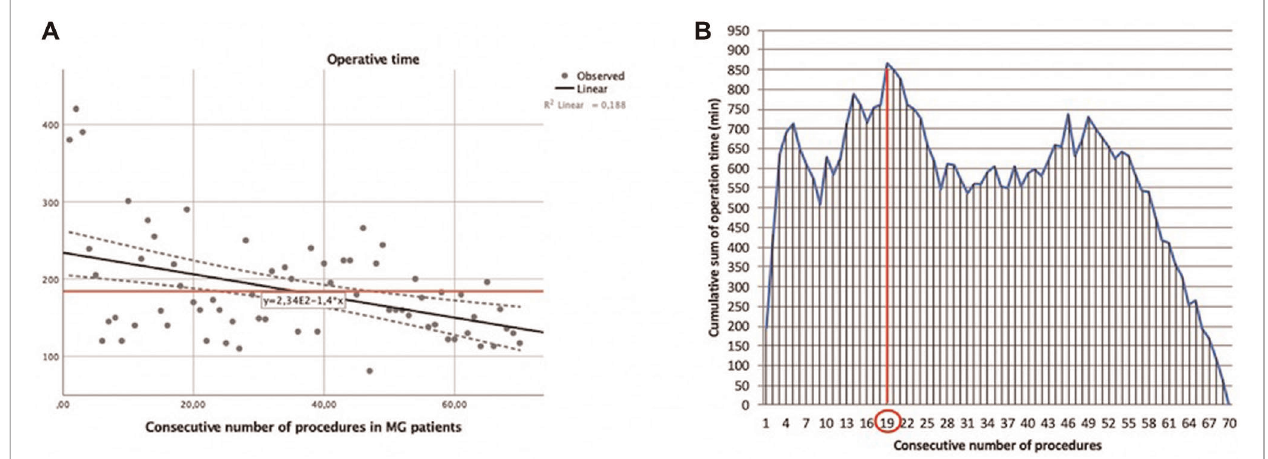
FIGURE 3 | Learning curve of robot-assisted myasthenic thymectomies. ( A ) Correlation between the operation time and the consecutive number of procedures [the red line represents the average time; the Pearson correlation coef fi cient ( r ) of linear function is − 0.433]; ( B ) cumulative sum (CUSUM) plot for the overall surgical time. The red circle is the CLC cut-off value on the plot of CUSUM analysis. CLC, completion of learning curve.